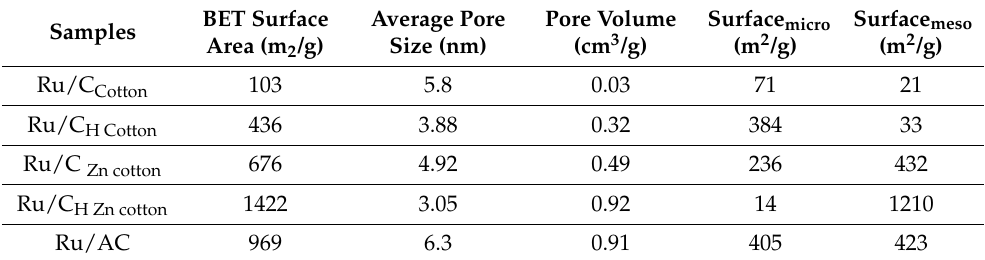
Table 2. Textural properties of the catalyst